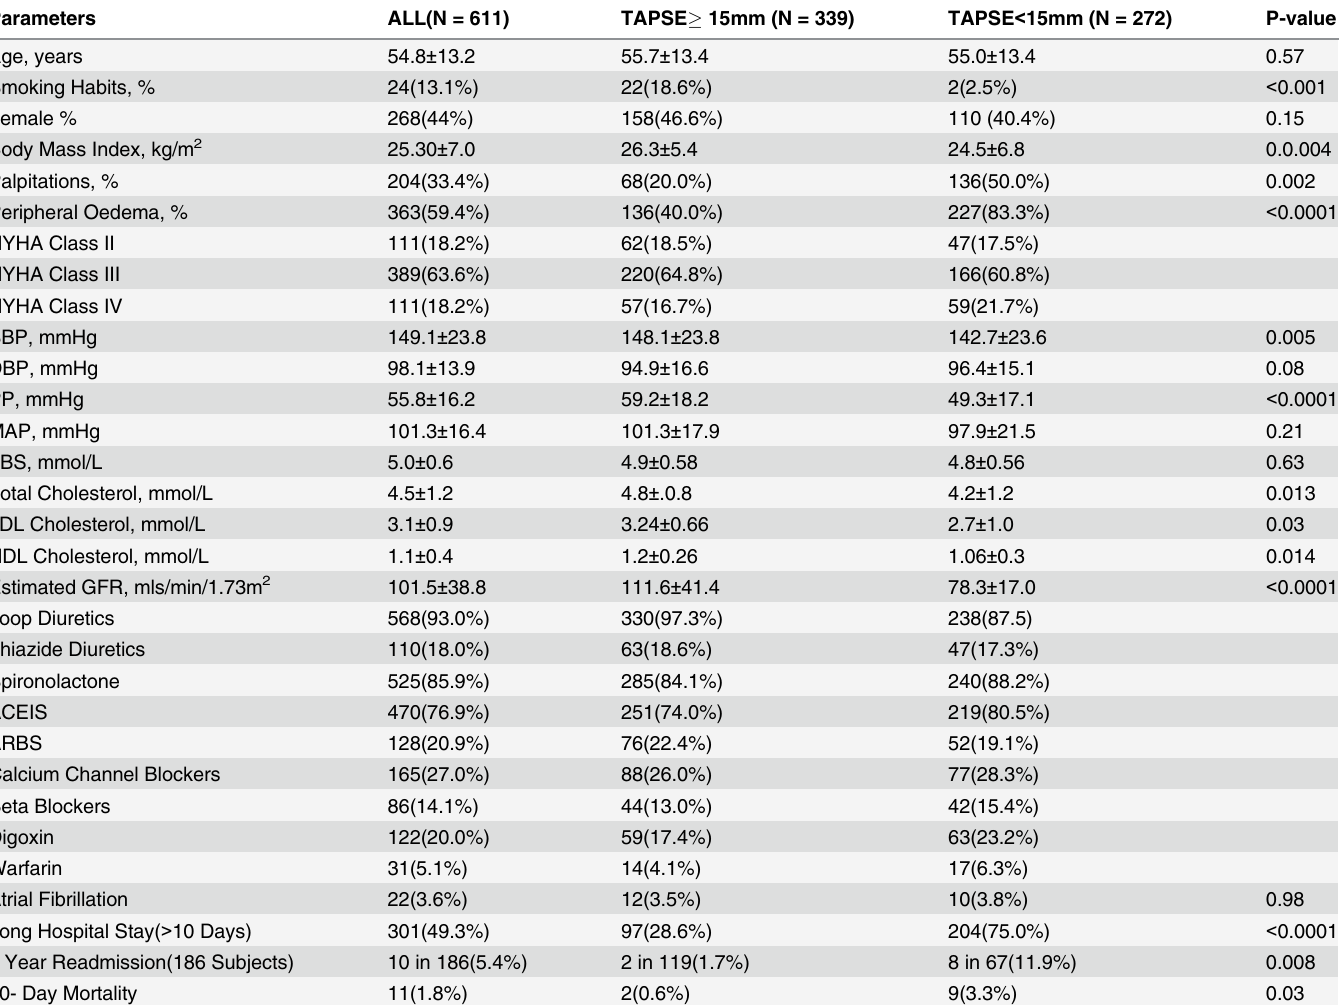
Table 1. Clinical Profile of the